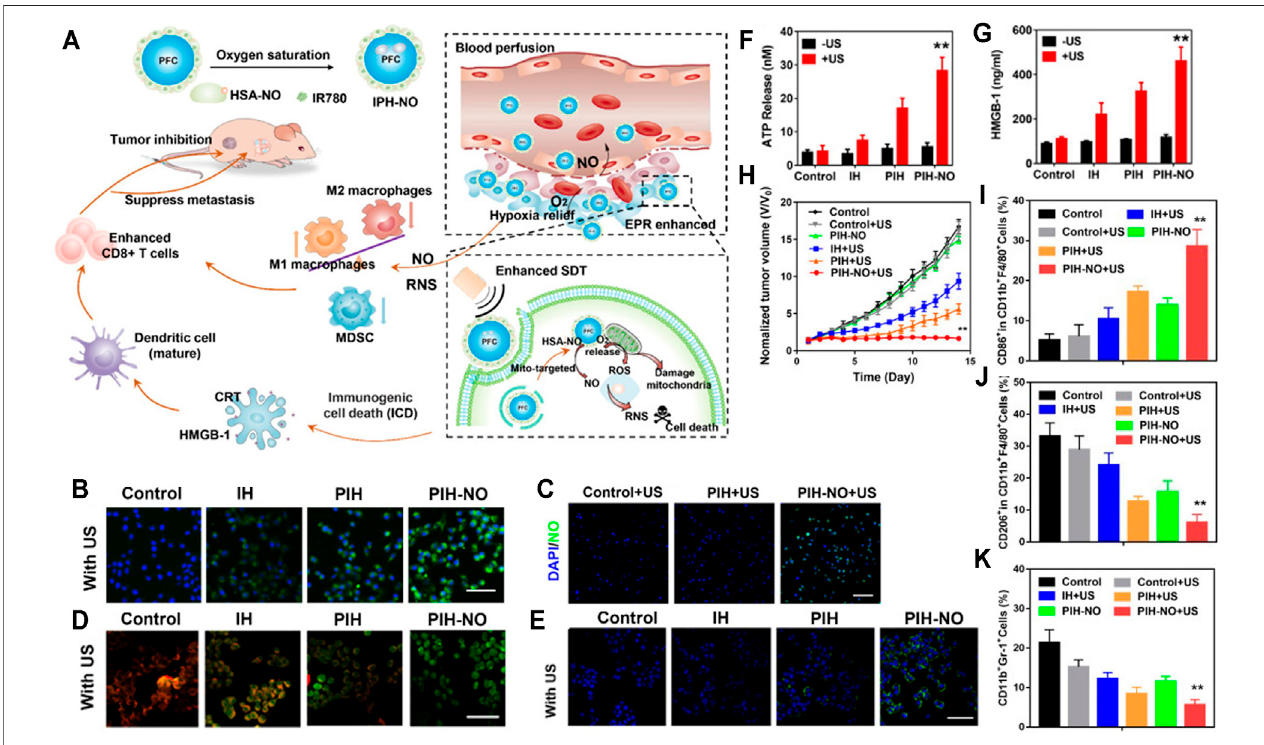
FIGURE 4 | (A) PIH-NO for enhanced SDT and immune response. PIH-NO was developed by HSA-NO-loaded PFC and IR780. After injection, it could achieve increasedblood perfusion andenhancedEPReffectaswellasrelieve hypoxia.Withultrasoundirradiation treatment,itcould quicklyreleaseO 2 and NOtofacilitateSDT, destroy mitochondria, and promote DC maturation. The production of NO and RNS could polarize M2 to M1 macrophages and decrease MDSC to reverse immunosuppressive TME. All of the above approaches facilitated CD8 + T-cell in fi ltration to inhibit tumor growth. (B) ROS production. (C) NO release after different treatments. (D) Mitochondrial damage (green fl uorescence indicated mitochondrial damage). (E) Calreticulin exposure, (F) ATP release, and (G) HMGB-1 release indicating immunogenic cell death. (H) Tumor growth curves after administration. (I, J) The proportion of M2 to M1 macrophages. (K) Percentages of MDSCs after administration (Ji et al.,